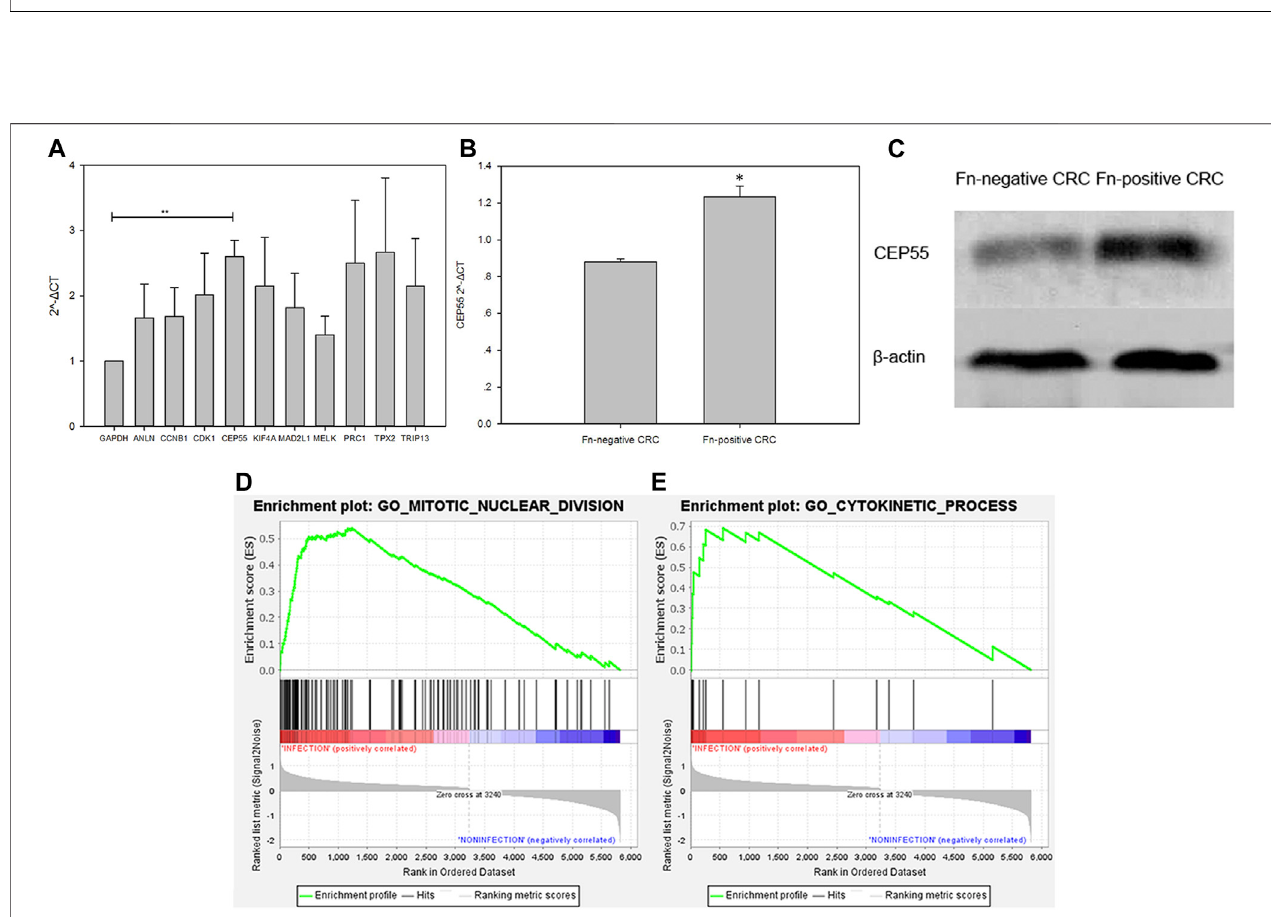
FIGURE 6 | Validation of the 10 upregulated hub genes in Fn-infected Caco-2 and CEP55 in Fn-infected CRC (A , B , C) and GSEA exhibition of two representative functional gene sets enriched in CRC with CEP55 highly expressed (D , E) .